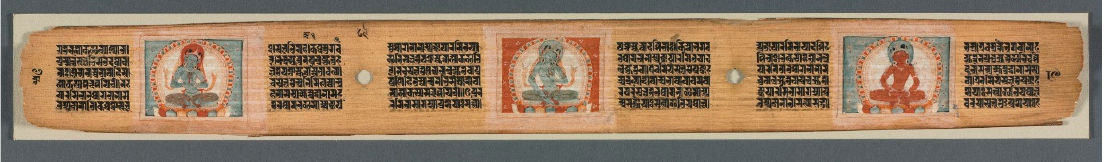
Figure 5. Prajñ ā p ā ramit ā flanked by a white female figure (left) and white bodhisattva (right), fol. 90r. Perfection of Wisdom in Eight Thousand Lines: A ṣṭ as ā hasrik ā Prajñ ā p ā ramit ā -s ū tra , 1119. India and Nepal. Gum tempera and ink on palm leaf. 6.1 × 55.8 cm. Cleveland Museum of Art, purchase from the J. H. Wade Fund, 1938.301.3. Figure 6. Preaching Amit ā bha with Avalokite ś vara (left) and Mañju ś r ī (right), fol. 186v. Perfection of Wisdom in Eight Thousand Lines: A ṣṭ as ā hasrik ā Prajñ ā p ā ramit ā -s ū tra , 1119. India and Nepal. Gum tempera and ink on palm leaf. 5.5 × 54.6 cm. Cleveland Museum of Art, purchase from the J. H. Wade Fund, 1938.301.4. Figure 7. Prajñ ā p ā ramit ā flanked by two bodhisattvas, fol. 187r. Perfection of Wisdom in Eight Thousand Lines: A ṣṭ as ā hasrik ā Prajñ ā p ā ramit ā -s ū tra , 1119. India and Nepal. Gum tempera and ink on palm leaf. 5.3 × 54.3 cm. Cleveland Museum of Art, purchase from the J. H. Wade Fund, 1938.301.5. Folio 1v likely had a facing illustrated page (folio 2r), but that palm leaf is now unfortunately lost. 7 Folio 2 would have included the last eight verses of the opening hymn, the Prajñ ā p ā ramit ā -stotra of R ā hula, that begins on folio 1v up to verse 13. 8 Also, folio 2 would have included the beginning of the proper text of the A ṣṭ as ā hasrik ā Prajñ ā p ā ramit ā , since folio 3r has a section that is already well into the text. In other words, there is a gap in the text that proves a page is absent, and it was most likely illustrated. 9 7